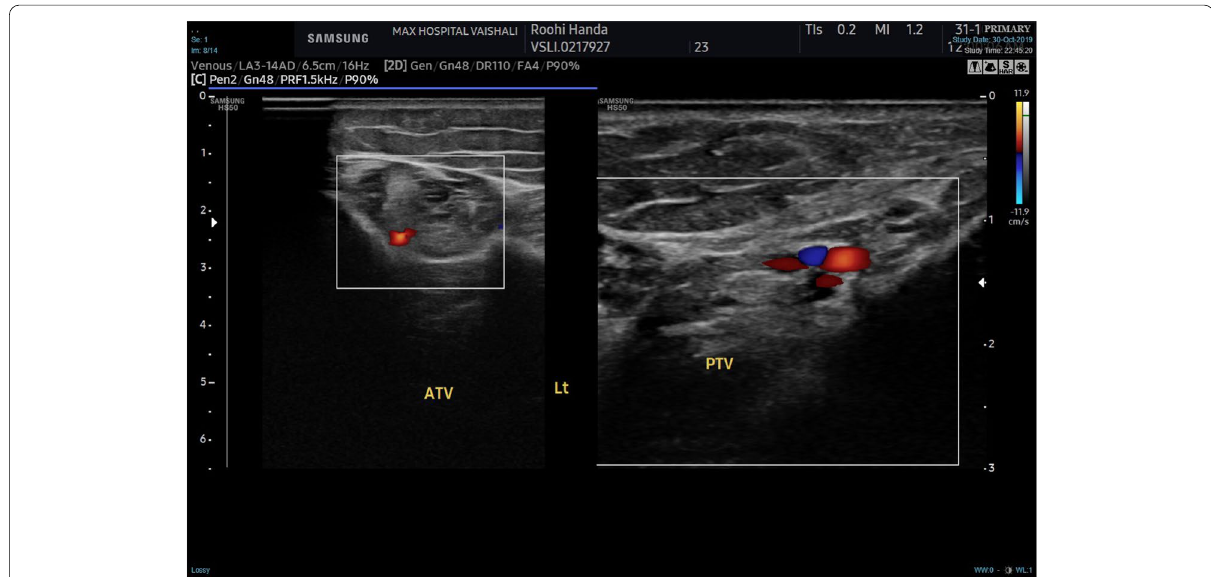
Fig. 5 Venous Doppler of the lower limb revealed deep vein thrombosis involving left common, external iliac, common, superficial and deep femoral, and popliteal veins with extension